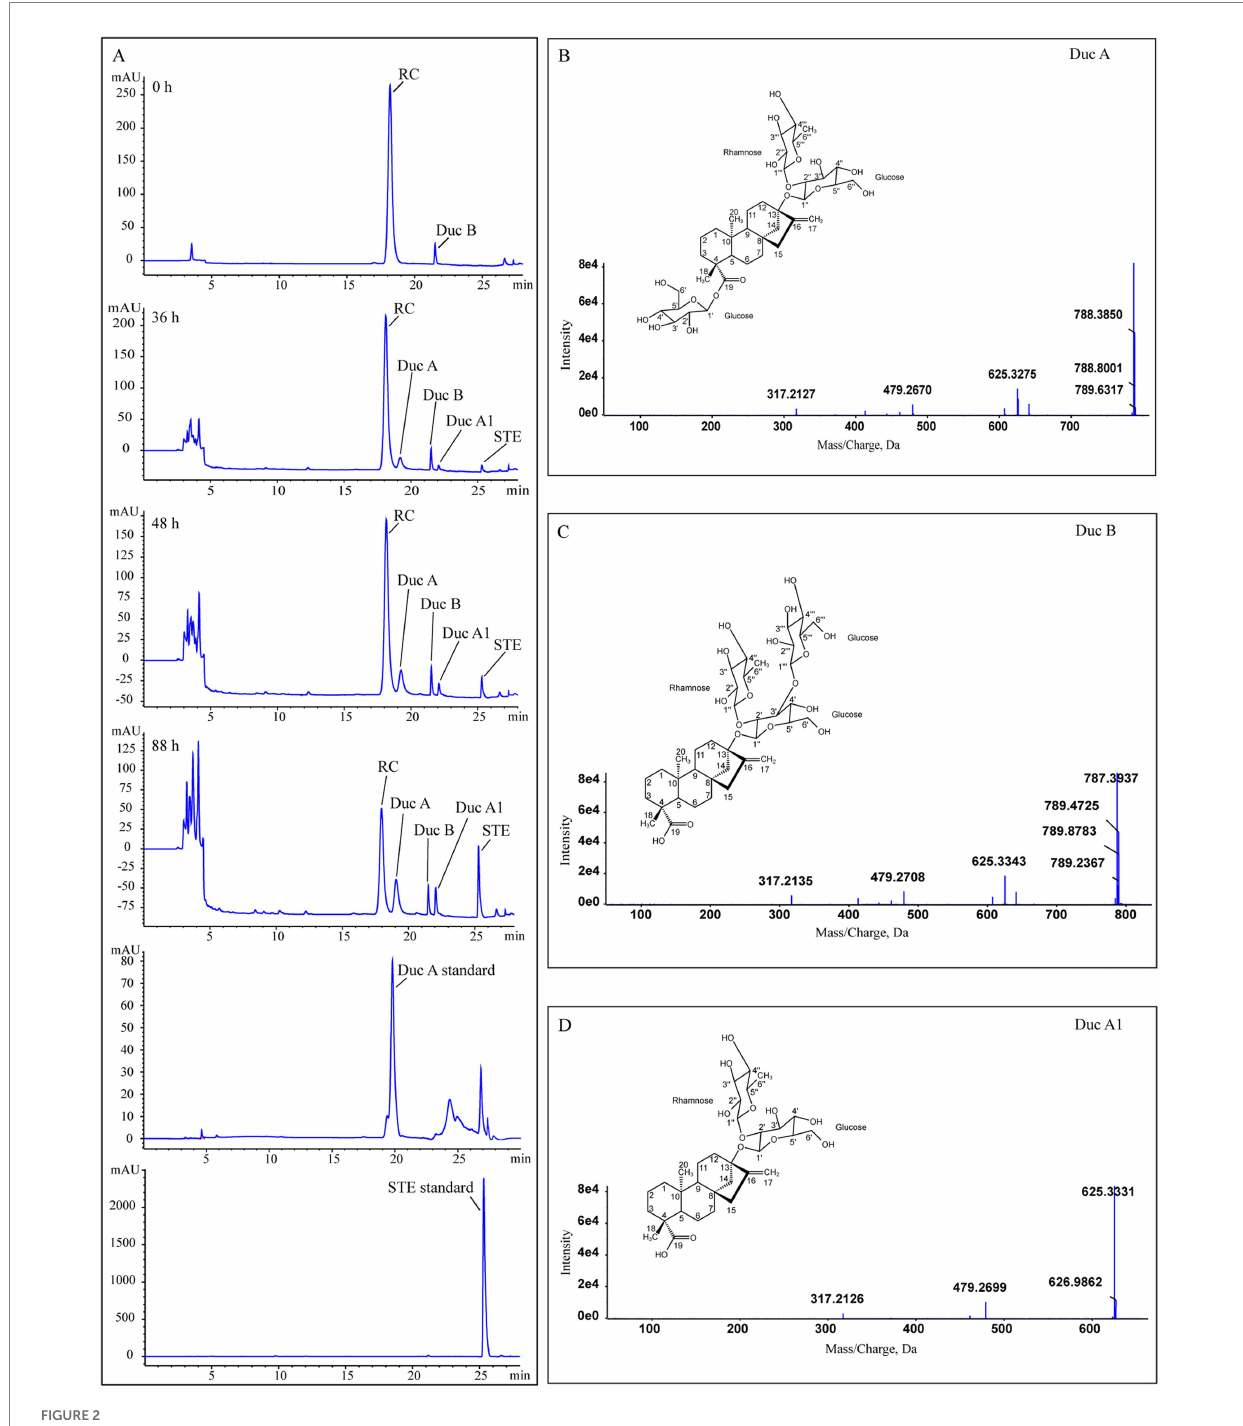
(Figure 8). The enriched GO terms contained 29 SDE genes,